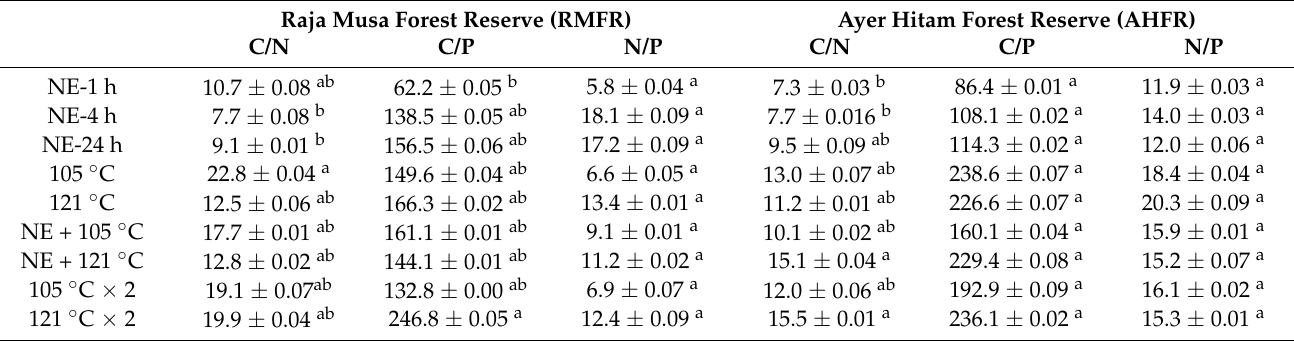
Table 2. Ratios of DOC to TDN and TDP, and TDN to TDP for RMFR and AHFR using different extraction methods. Raja Musa Forest Reserve (RMFR) Ayer Hitam Forest Reserve